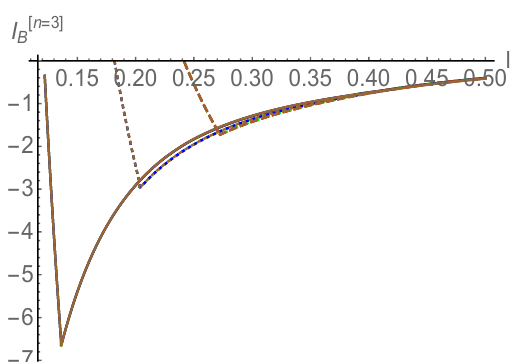
as Figure 34 . Tri-partite information I [ n =3] B a function of x for various values of chemical potential in the specious con(cid:12)ned phase. Here T = 0 : 9 T c and solid, dotted and dashed lines correspond to ‘ =0 : 3, 0 : 4 and 0 : 5 respectively. The red, green, blue and brown curves corre- spond to (cid:22) = 0, 0 : 1, 0 : 2 and 0 : 3 respectively. In units